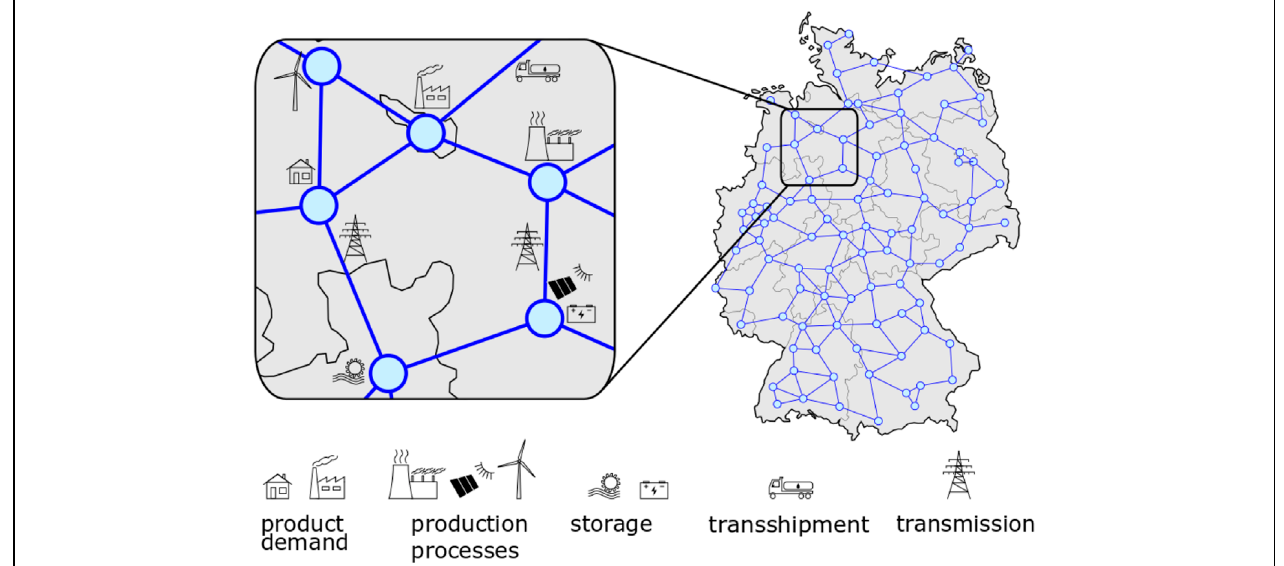
FIGURE 3 | Exemplary topology of a spatially resolved energy system with nodal energy demands. Production and storage processes are located at nodes and transport processes (transmission and transshipment) are located at edges.